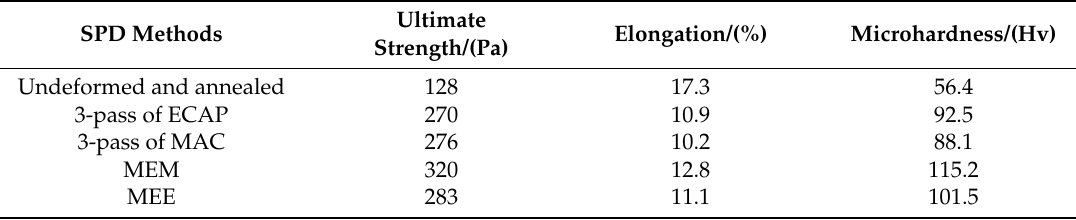
Table 2. Mechanical properties of 6061 aluminum alloy processed by different SPD (Severe plastic deformation) methods.